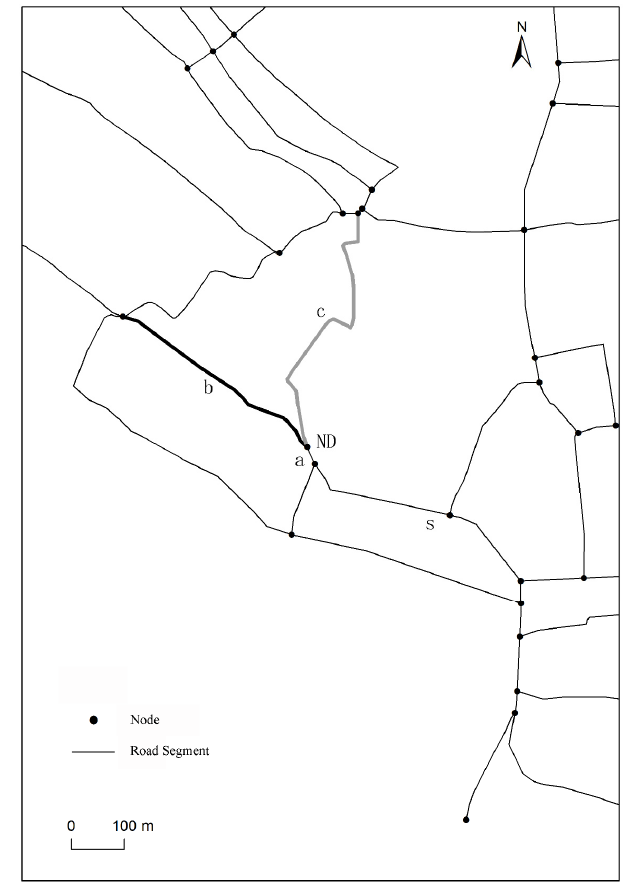
Figure 10. Local contrast for stroke generation.